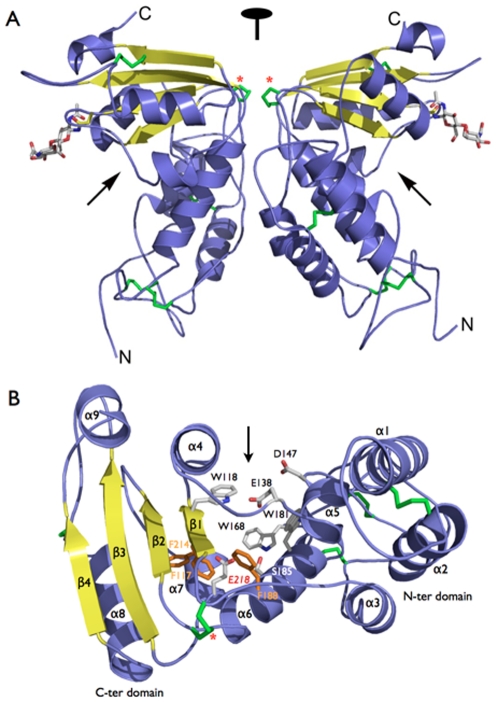
Overview of the structure of bCD38 and its active site.(A) Structure of the homodimer of the ecto-domain (Δ31) of wt apo bCD38 observed in the asymmetric unit; the non-crystallographic two-fold axis is indicated. (B) The active site of bCD38. The side chains of selected residues participating to the catalytic activity of the enzyme are indicated in grey. The phenylalanine ‘plug’ is in orange. Catalytic residue Glu218 sits at the bottom of the active site pocket. Secondary structure elements are labeled. The N- and C- terminal domains are indicated. The five disulfide bonds stabilizing each monomer are depicted in green and a red asterisk indicates the disulfide bond specific to CD38 that stabilizes its hinge region. The sugar chains bound to residues Asn201 are shown in stick representation. The active sites are indicated with arrows.